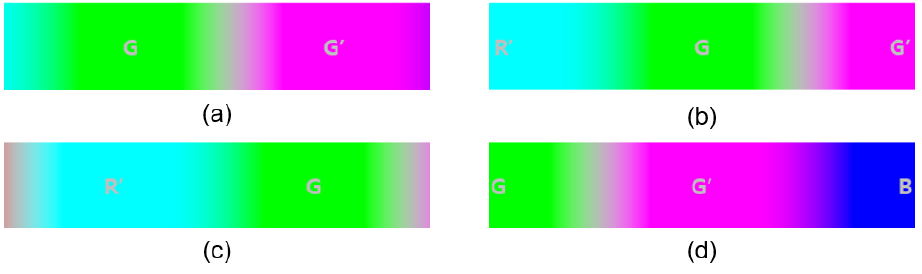
Figure 6. Four different patterns in color barcodes: ( a ) GG’, ( b ) R’GG’, ( c ) R’G, ( d )